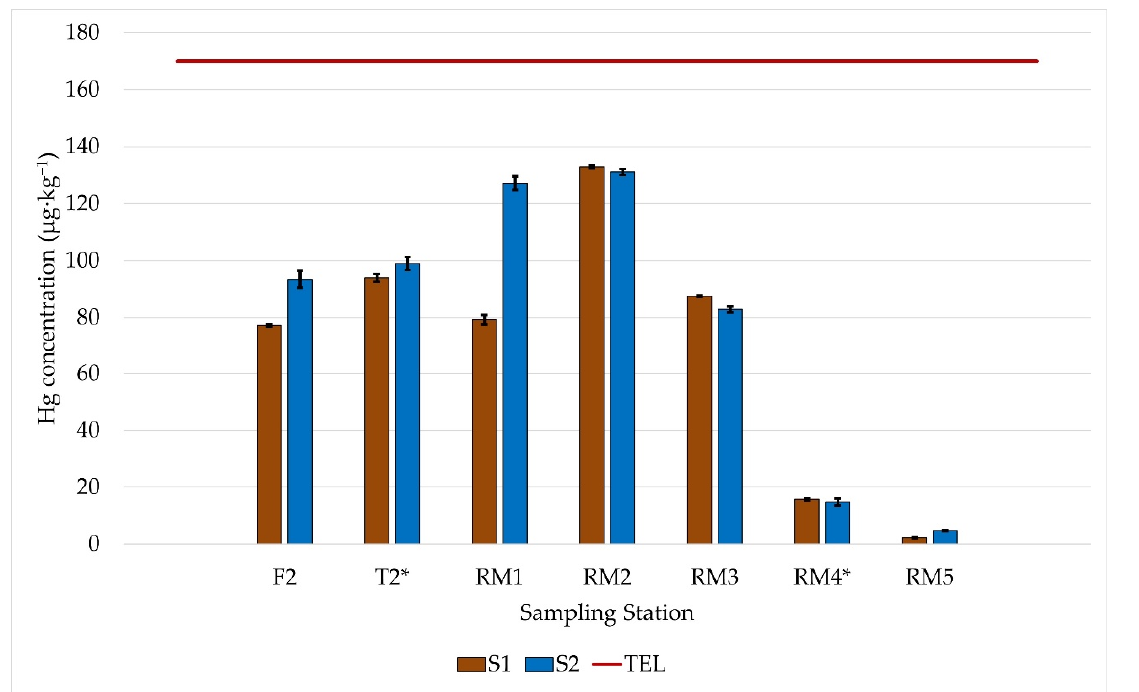
Figure 2. Hg concentration determined in sediment samples collected at different stations of the Rio Reis Magos River Hydrographic Basin in sampling S1 and S2. (-) Limit of concentration below which there is less possibility of an adverse effect on the biota (TEL). * No statistical differences with 95% confidence level of Hg concentration between the sampling periods.